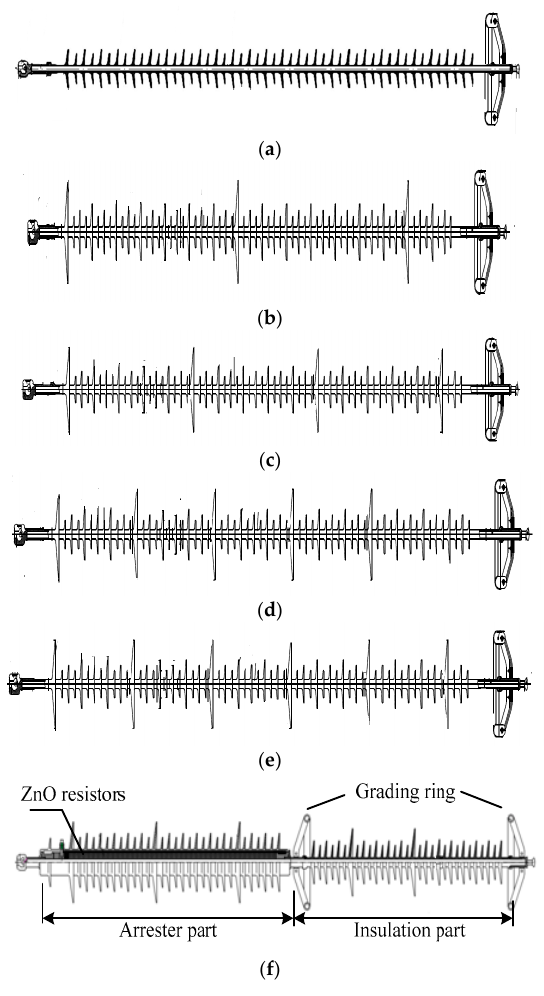
Figure 3. Profiles of the test specimens ( a ) Type A; ( b ) Type B; ( c ) Type C; ( d ) Type D; ( e ) Type E; and ( f ) Type F.